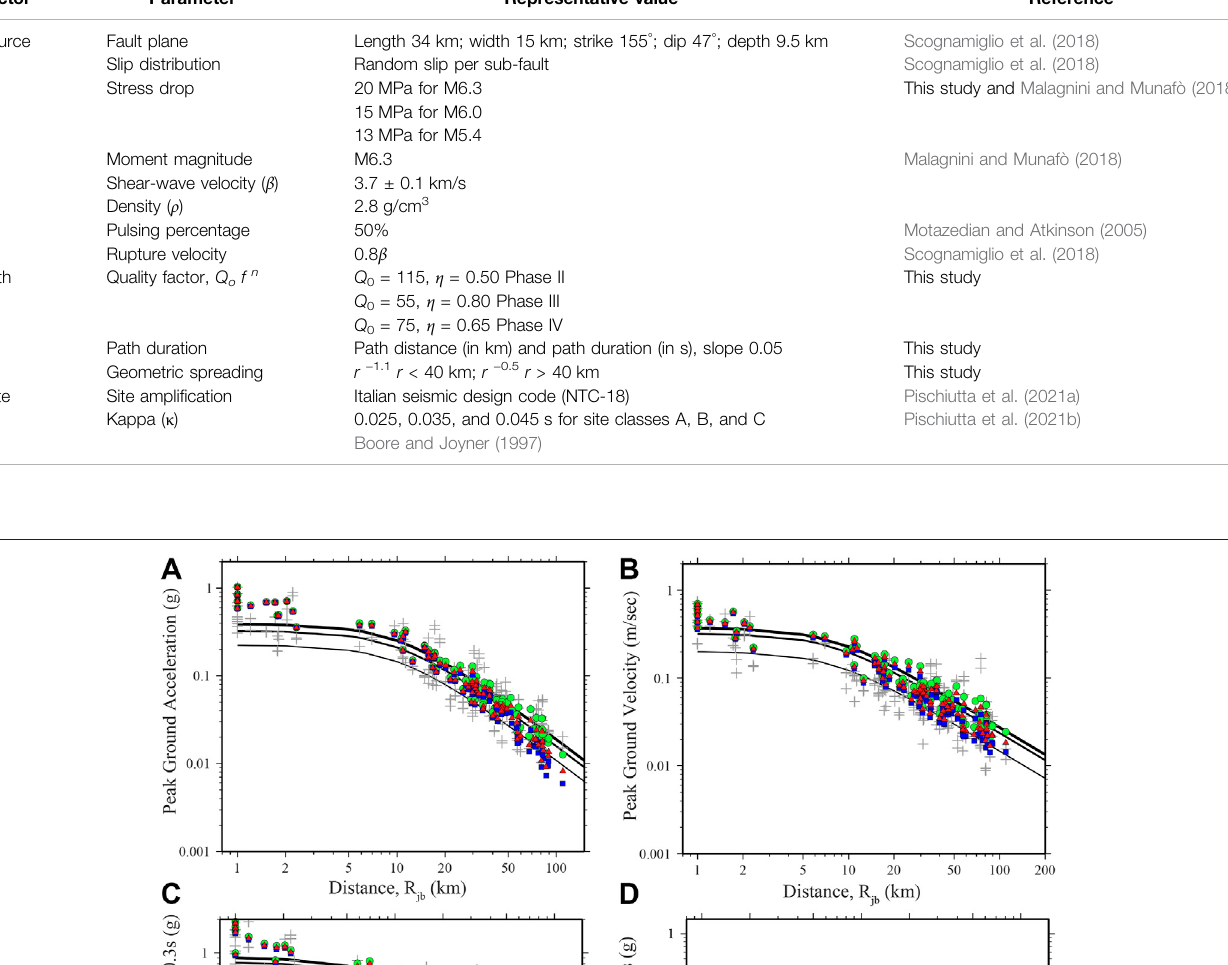
Figure 6 ) during the Visso sequence with Q( f ) = 55 ± 5 f 0.80 ±